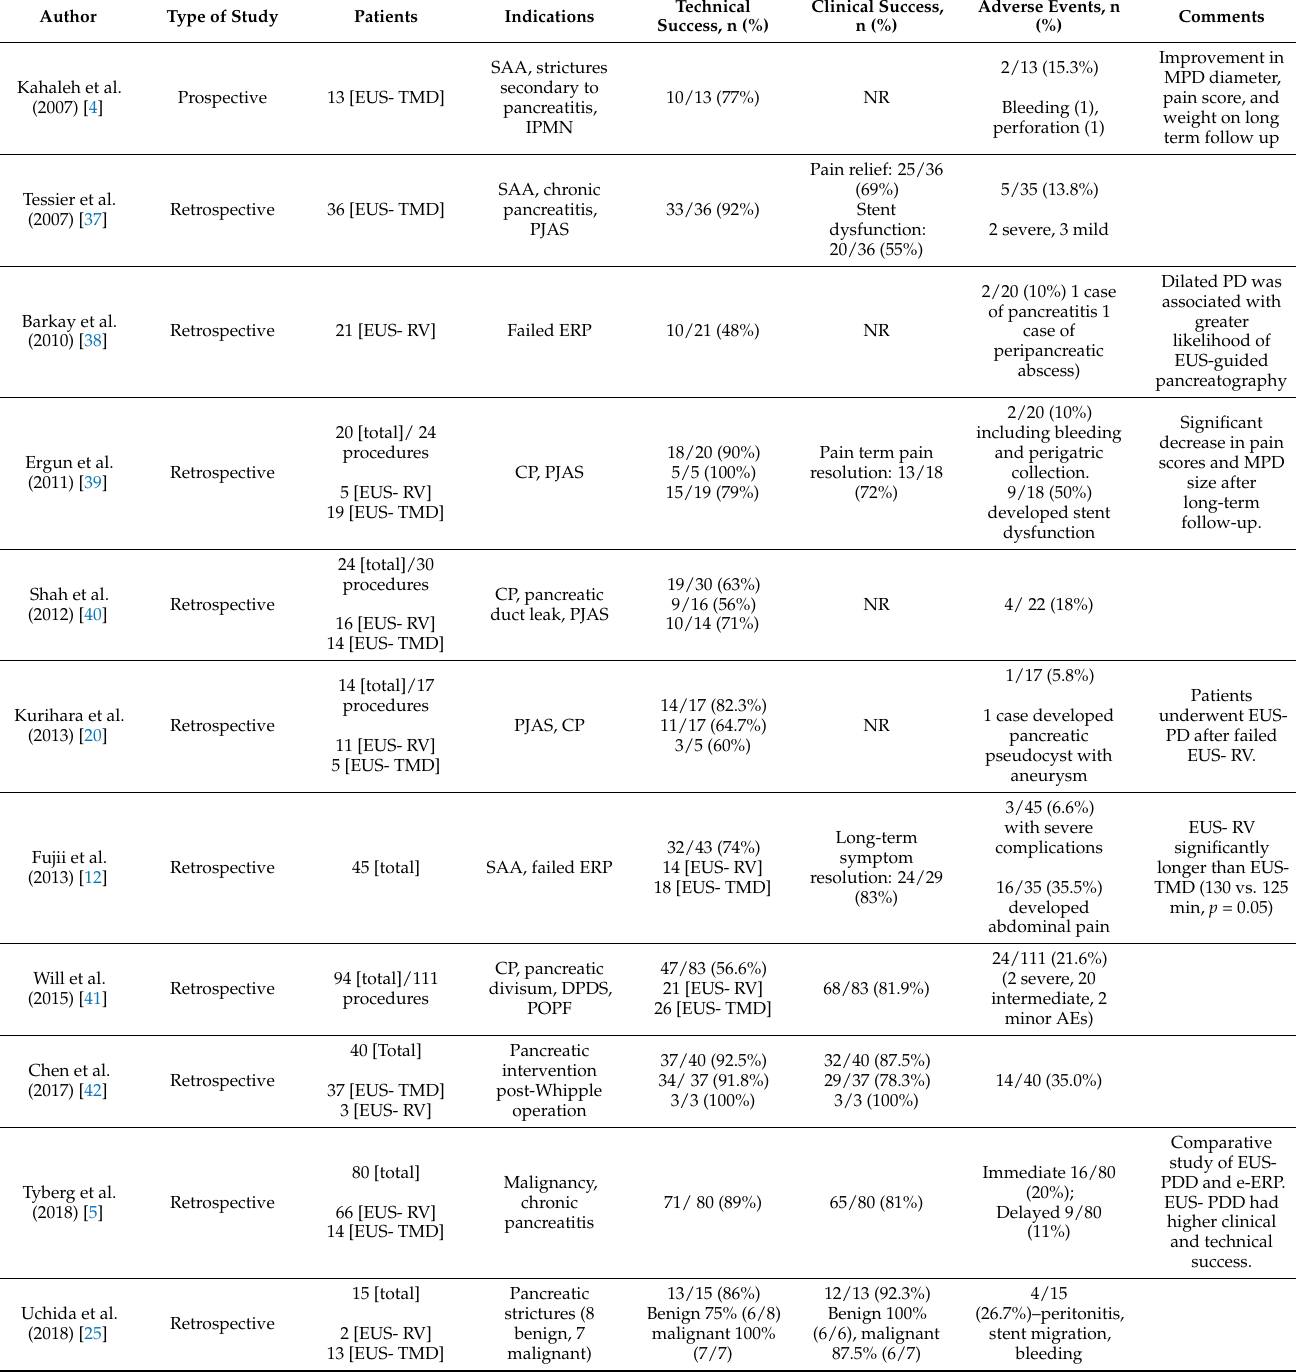
Table 2. Outcomes of EUS-guided pancreatic duct